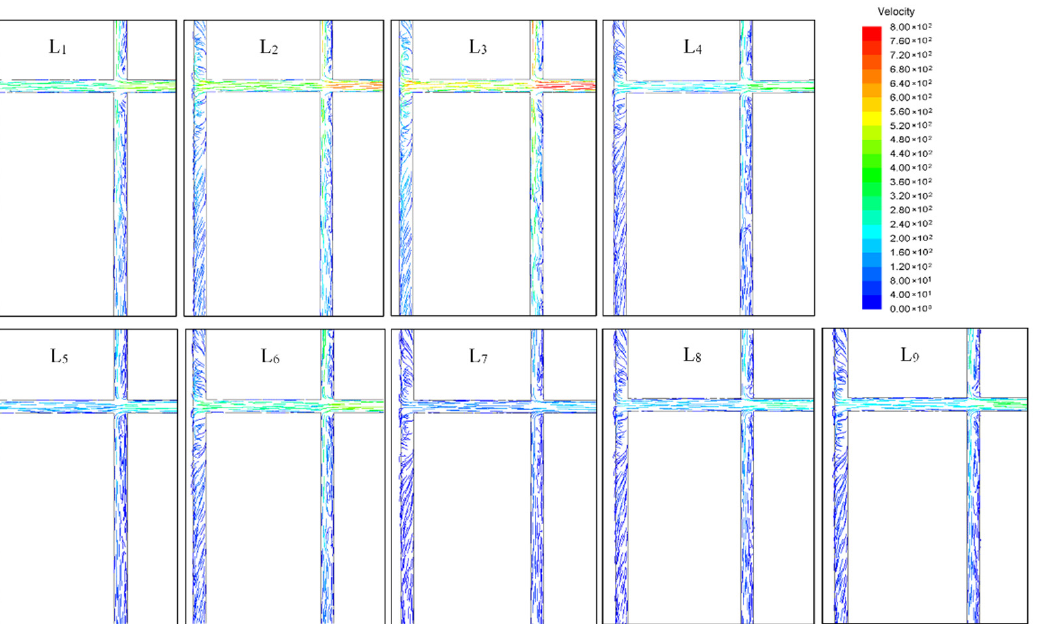
Figure 7. Air velocity of Inlet 1 of the intake airway. As can be seen from the contour map in Figures 6 and 7, all inlet boundaries are reversed in each test, and the air velocity of Inlet 2 is larger than Inlet 1. Therefore, the influence of the gas outburst accident on the return air system is greater than that on the inlet air system. Extracting the maximum air velocity of the section, the airflow reversal degree is calculated, as shown in Table 4. Meanwhile, the variation curve of air velocity and airflow reversal degree is shown in Figure 8. Table 4. Air velocity and airflow reversal degree of the inlet boundary. Test